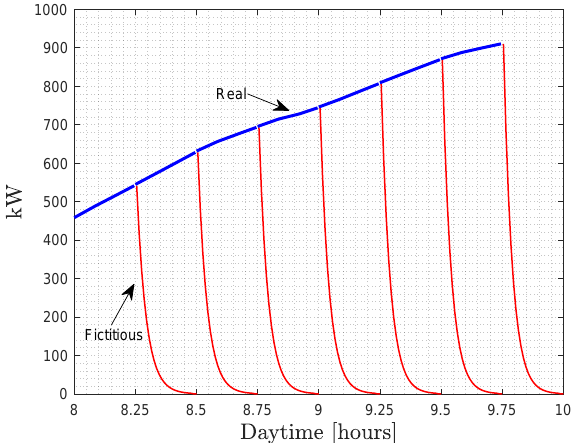
Figure 11. Section of solar power curve in the sunny day case with fictitious added parts